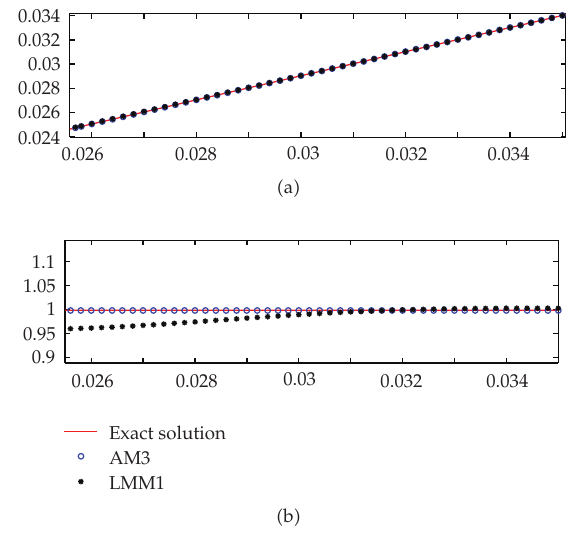
Figure 4: Comparison of exact solutions with numerical solutions for (cid:3) 5.6 (cid:4) .